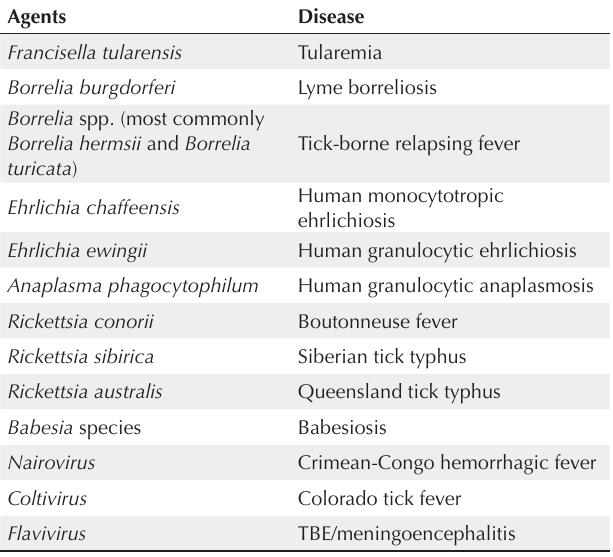
Table 2. Major Tick-Borne Infections and Etiological Agents Agents Disease